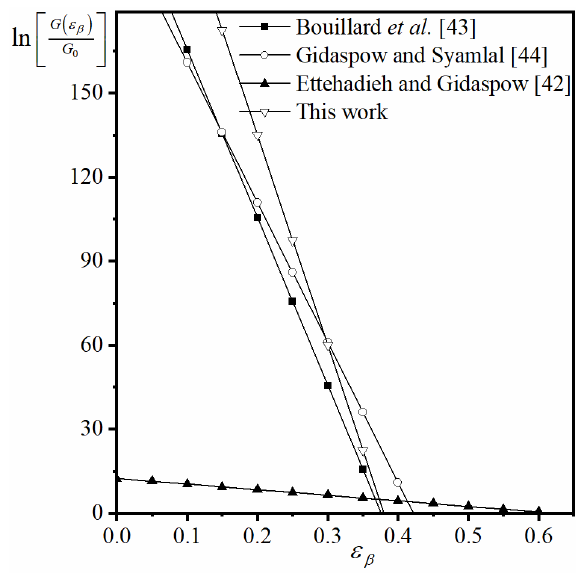
Figure 4. Comparison of the predicted modulus of elasticity of the different sub-models tested. The second sub-model included is a volumetric momentum exchange term, the drag force ( F d ) , which accounts for the multiphase interactions. As noted on Equations (2) and (4), the